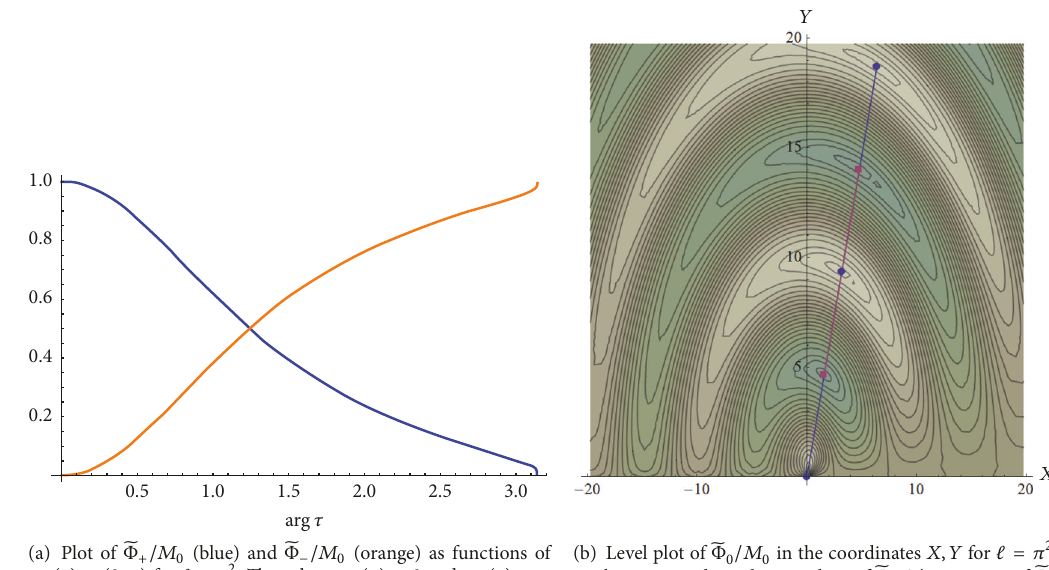
Darker tones indicate lower values of ̃Φ 0 . The maxima of ̃Φ 0 are indicated as blue dots, while the minima are shown as ̃Φ ̃Φ 𝜇 = 2 ( ℓ = 𝜋 2 , 𝑅 = 𝑒 ). ± and 0 for the annulus of modulus